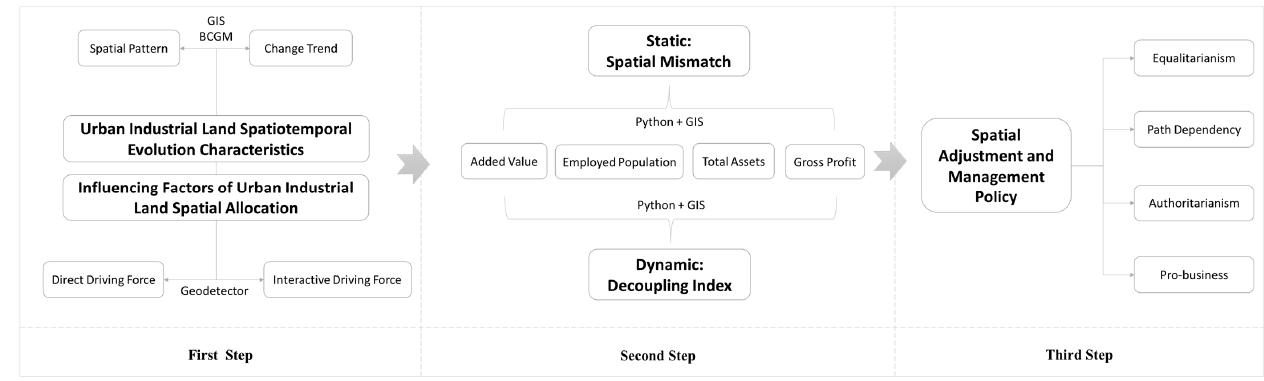
Figure 4. Research Figure 4. Research steps.